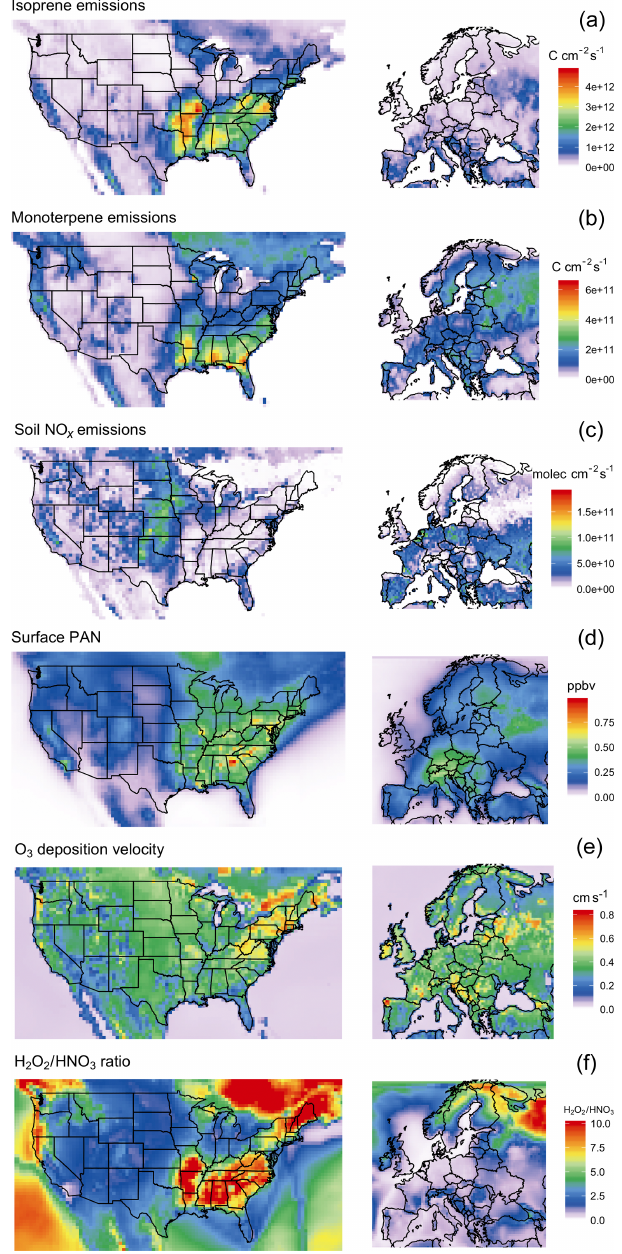
Figure 2. Summer mean values (JJA 2010–2011) for modeled iso- prene and monoterpene emissions (a, b) , soil NO x emissions (c) , surface PAN mixing ratios (d) , O 3 deposition velocity (e) , and NO x / VOC sensitivity as represented by the surface H 2 O 2 / HNO 3 ratio (f) .